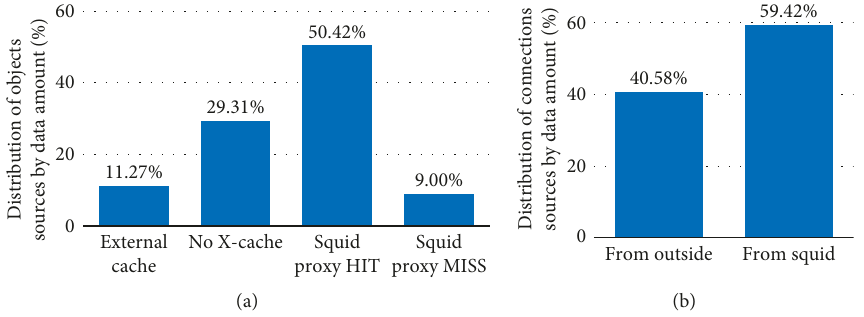
Figure 4: Objects and connections distribution in different cache